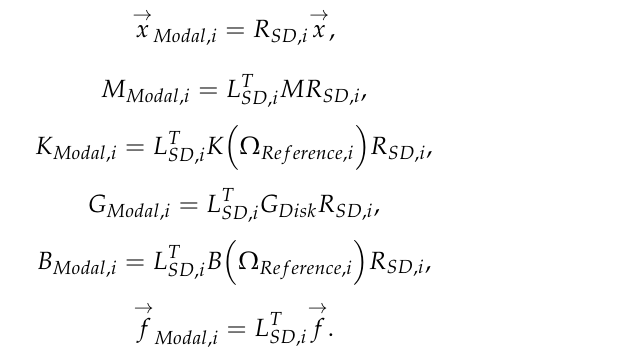
(cid:16) Ω Reference , C Reference ,